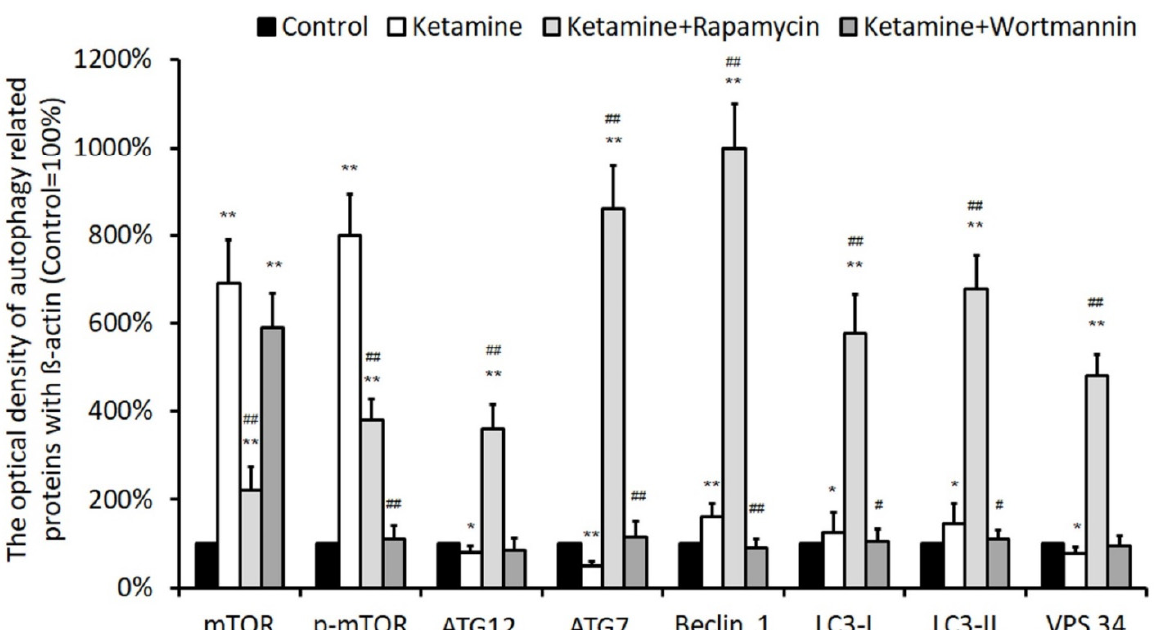
Figure 4. Treatment with rapamycin altered the expression of autophagy-associated proteins. ( A ) Representative western blots of autophagy-related genes are expressed: mTOR, mammalian target of rapamycin; ATG, autophagry-related protein; LC3, microtubule-associated protein 1A/1B-light chain 3; VPS 34, vacuolar protein sorting 34. ( B ) Protein expressions of autophagy-associated proteins were quantified against ß-actin. Results were normalized to the control group (100%). The protein level of autophagy-related genes was significantly increased in the ketamine+rapamycin group. However, this level was significantly decreased in the ketamine+wortmannin group. Values were presented as the mean ± SD, * p < 0.05, ** p < 0.01 versus control group; # p < 0.05, ## p < 0.01 versus ketamine group.